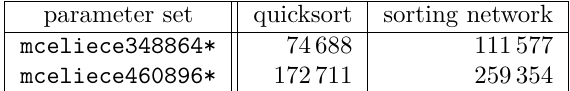
Table 4: Average cycle counts to generate the error